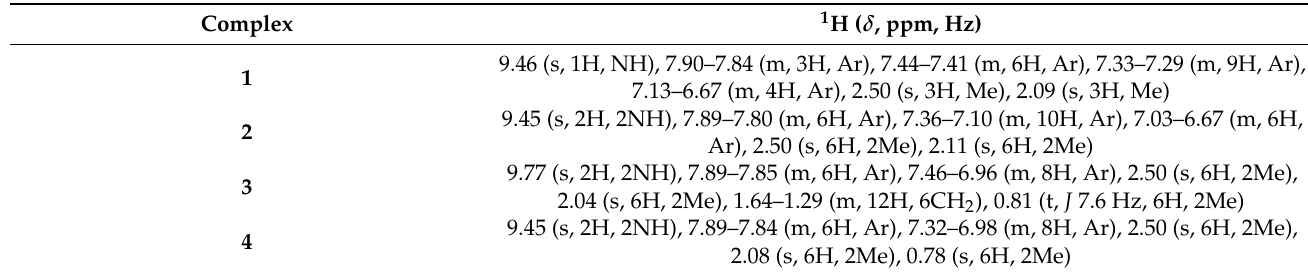
Table 3. 1 H NMR data (DMSO- d 6 ) of 1 – 4